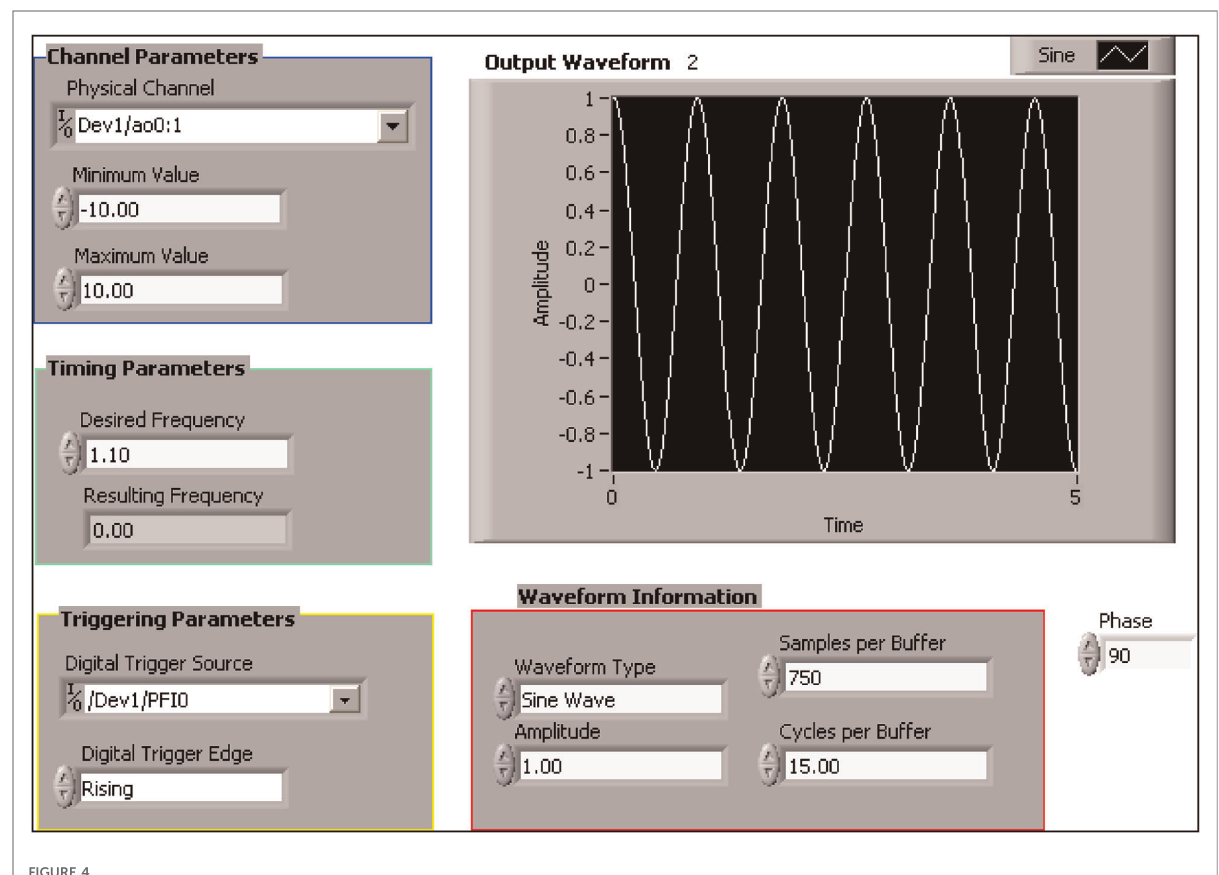
FIGURE 4 Frontal panel of the LabVIEW program to generate the sinusoidal signal.